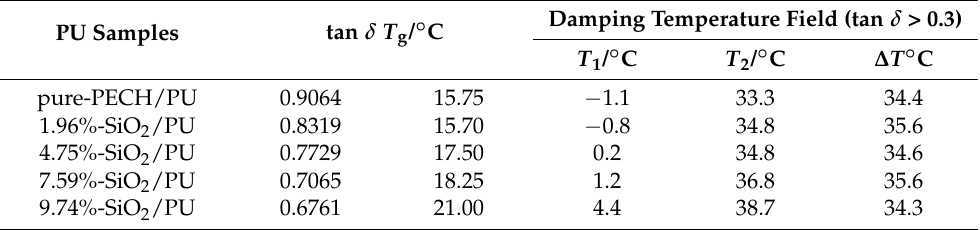
Table 9. Summary of DMA data of PU Composites with traditional nano- SiO 2 .